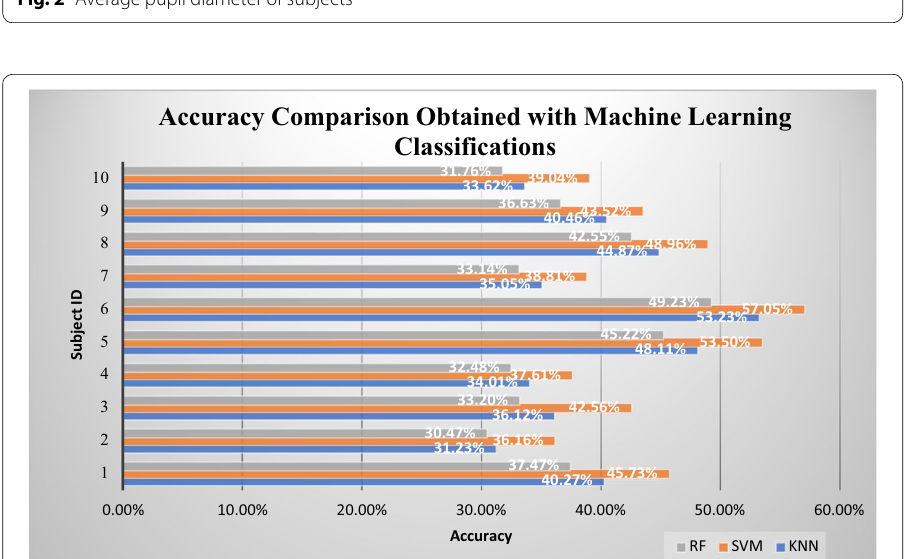
Fig. 2 Average pupil diameter of subjects